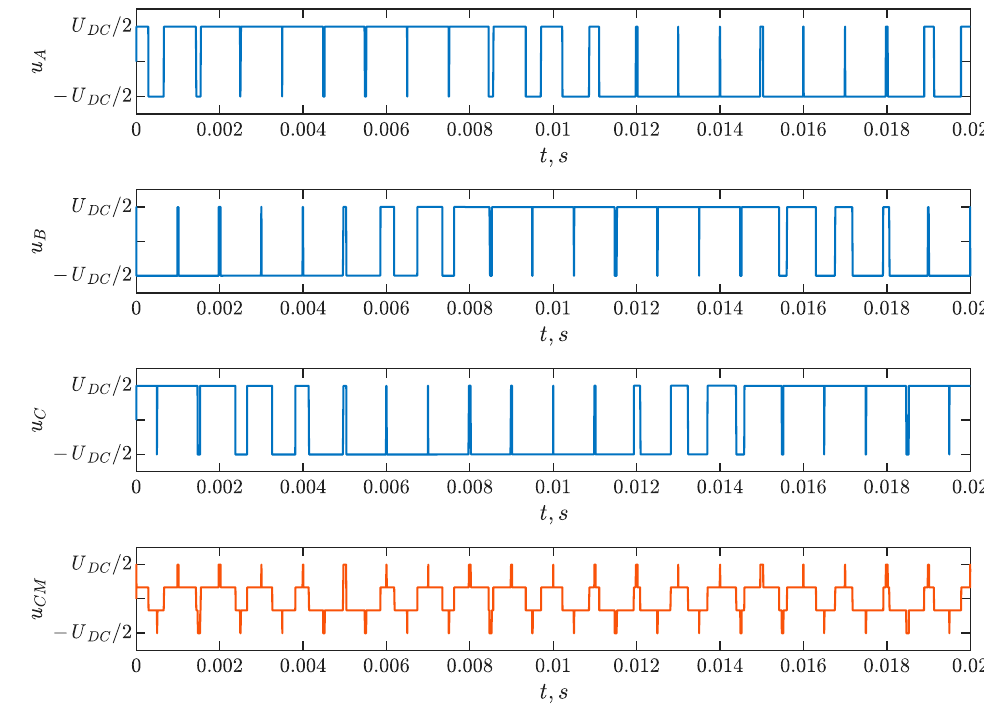
Figure 4. Sample waveforms of the phase output voltages of a two-level frequency converter u A , u B , u C and the common-mode voltage u CM .